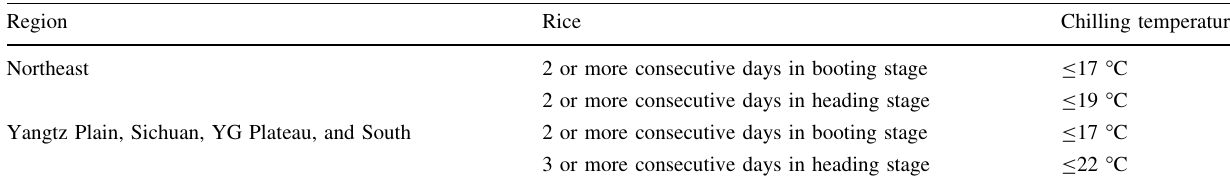
Table 4 Low temperature threshold for rice in different regions. Source CMA (2013) Region Rice Chilling temperature Northeast